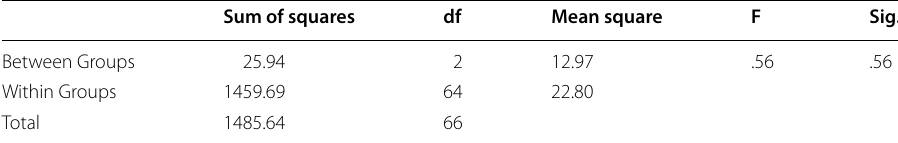
Table 5 Descriptive statistics of TST, posttest N Mean SD Std. error 95% confidence interval for mean Min Max Lower bound Upper bound EI 23 28.17 36.50 SI 19